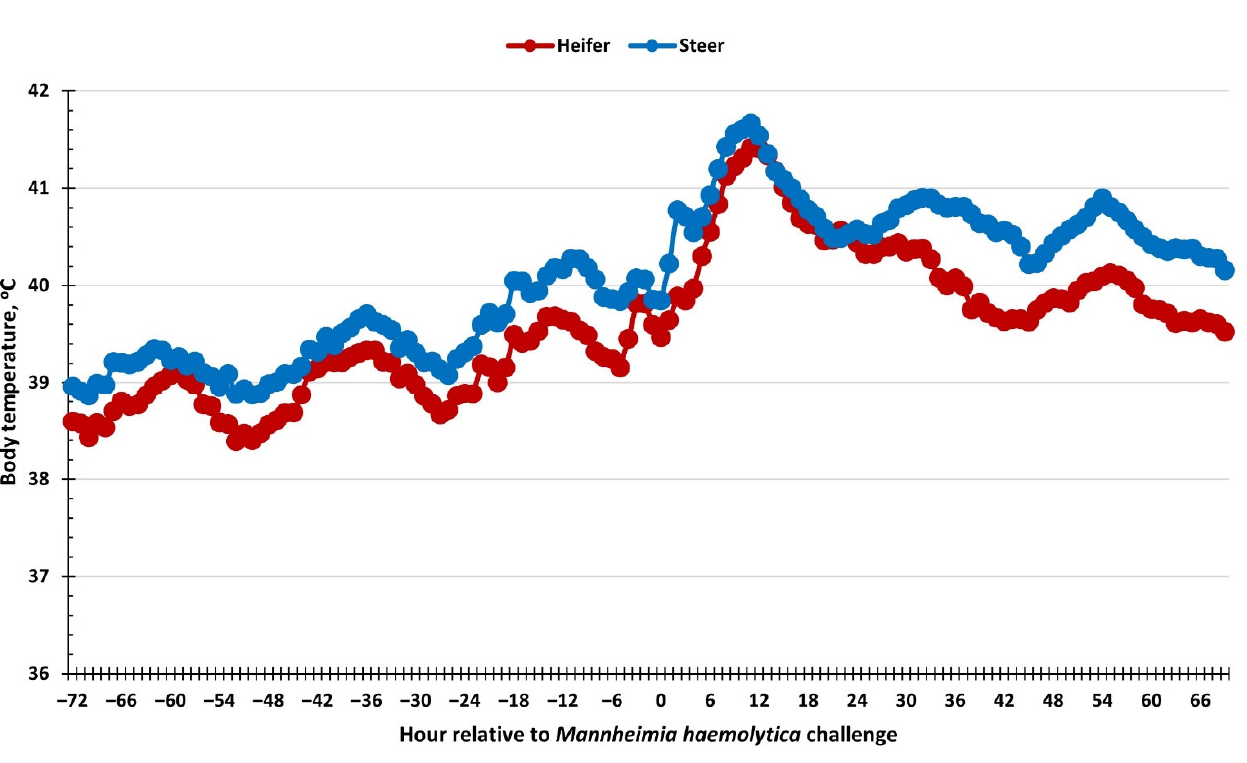
Figure 1. Influence of calf sex on the body temperature response to a dual viral–(bovine herpesvirus-1; 1 × 10 8 pfu/nostril) bacterial ( Mannheimia haemolytica ; 1.3 × 10 7 cfu) respiratory disease challenge. Rectal temperature was measured every 5 min and averaged across hours from −72 to 69 h relative to the challenge with Mannheimia haemolytica . Body temperature increased ( p < 0.01) following Mannheimia haemolytica challenge and was reduced in heifers compared to steers (sex: p < 0.01). SEM ± 0.22 °C.